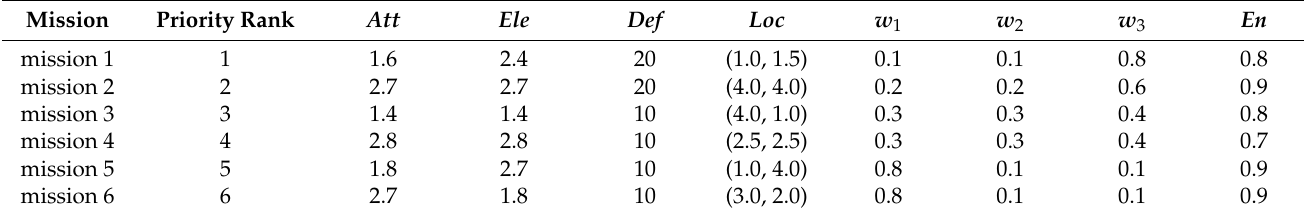
Table 5. Mission settings.